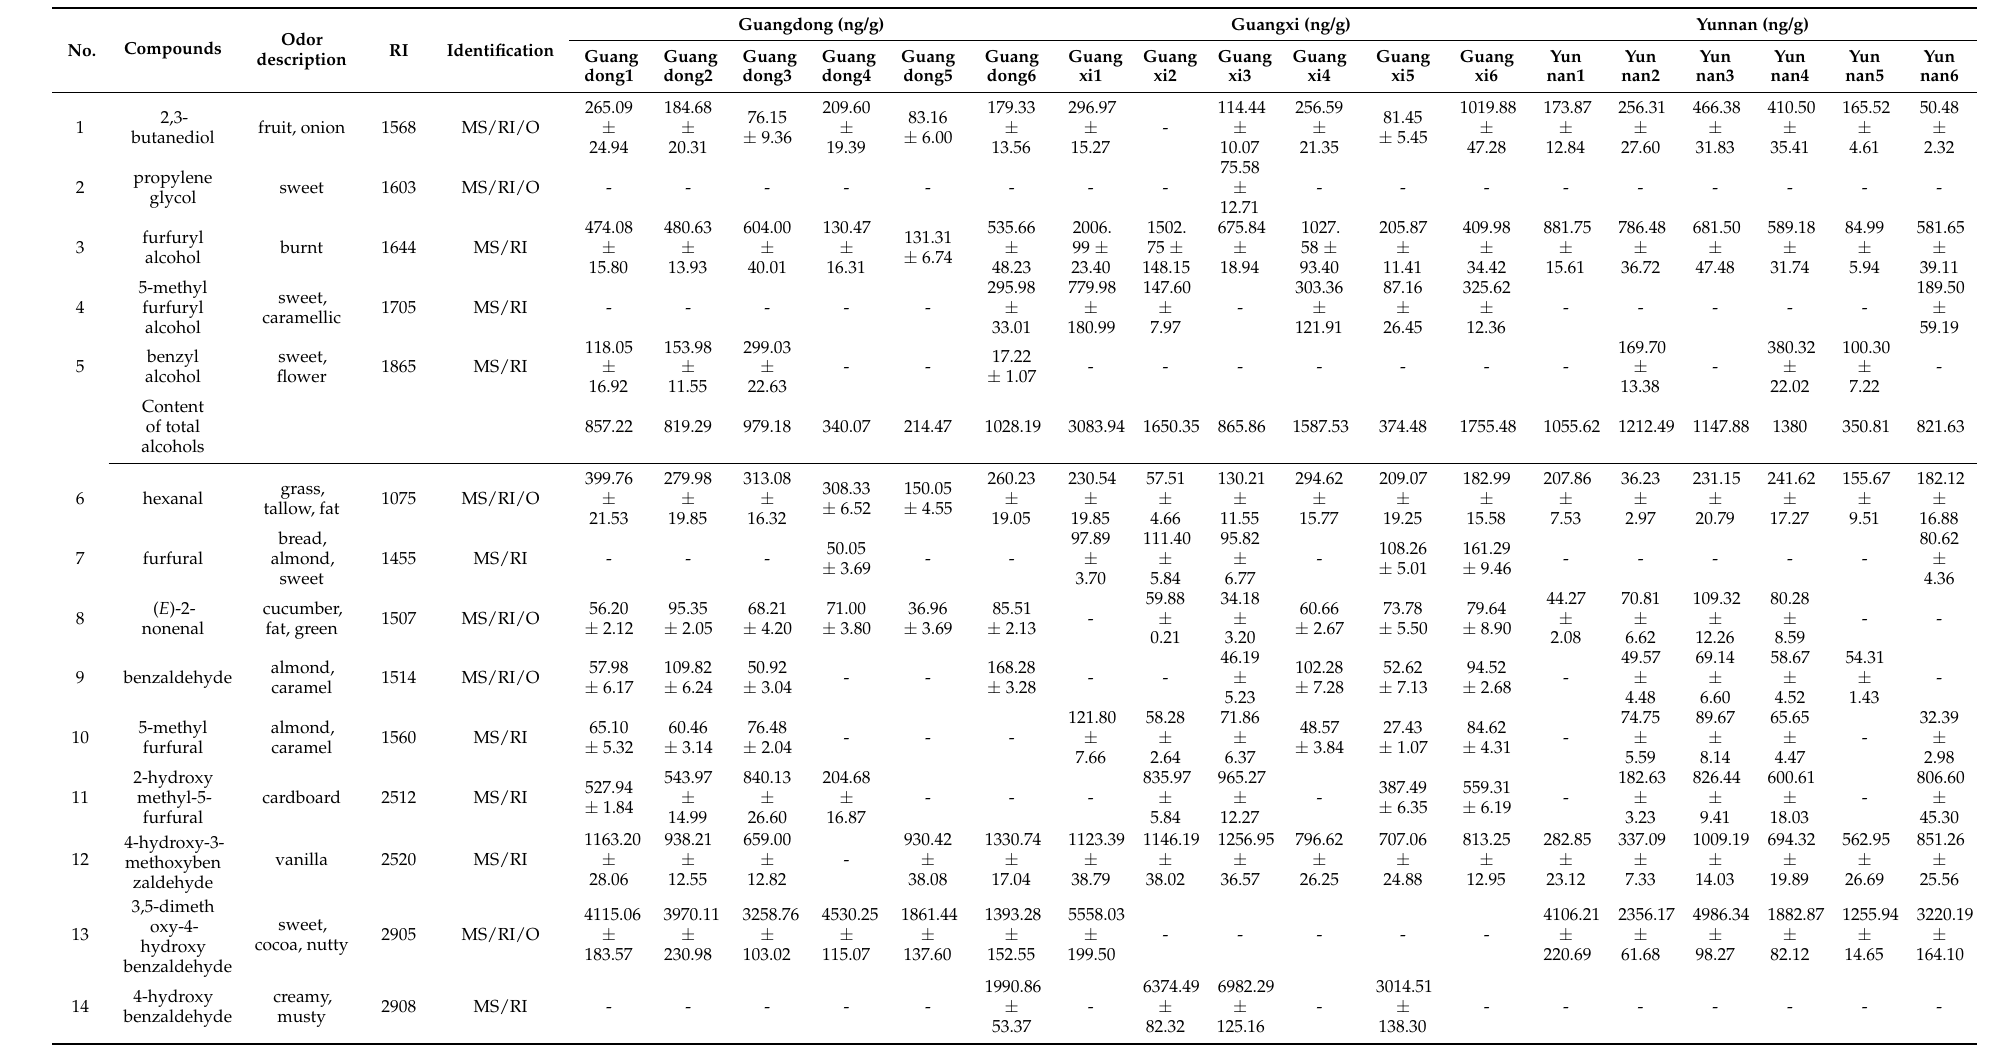
Table 1. Volatile aroma components of brown sugars from different producing